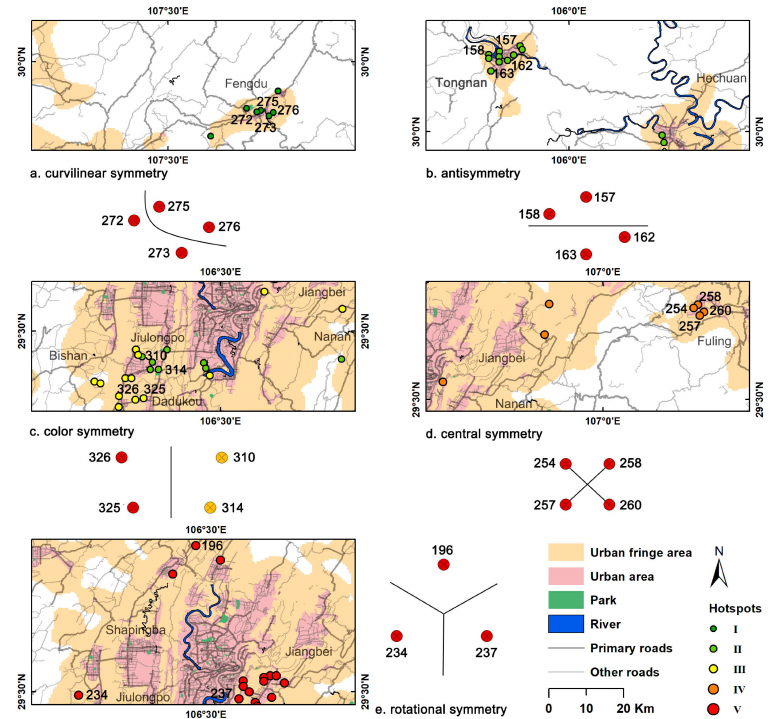
Figure 16. Extraction results of the generalized symmetric structure Tupu for hotspots (UFAs of